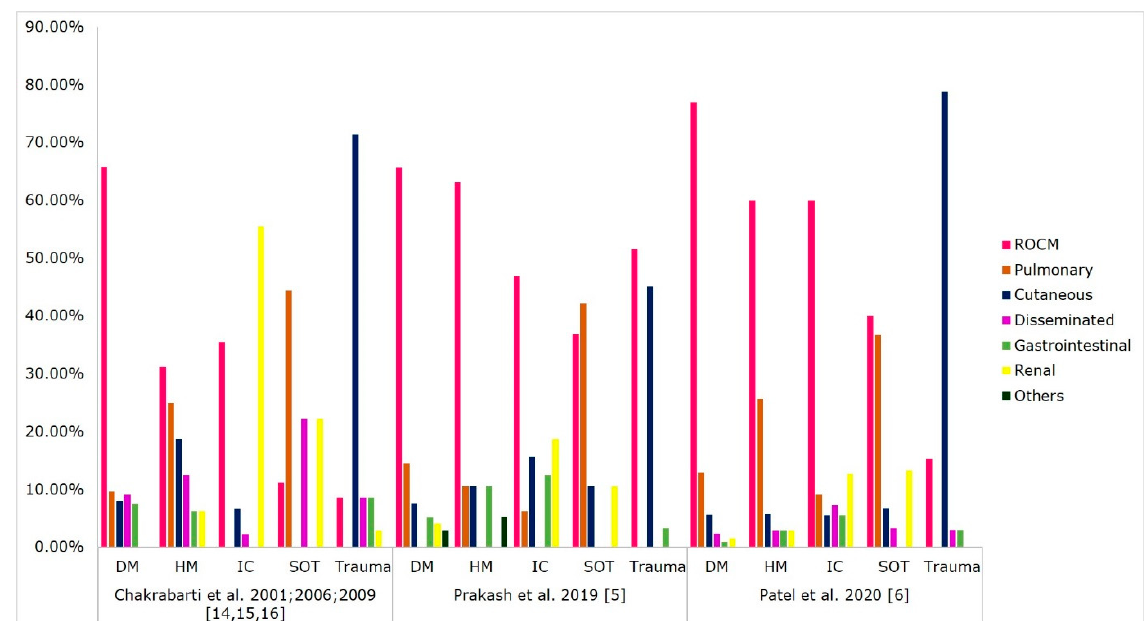
Figure 1. Clinical forms of mucormycosis in India. Abbreviations: ROCM, rhino-orbital-cerebral mucormycosis. Others included mucormycosis of the oral cavity, otitis media, subglottis, and bone infections.